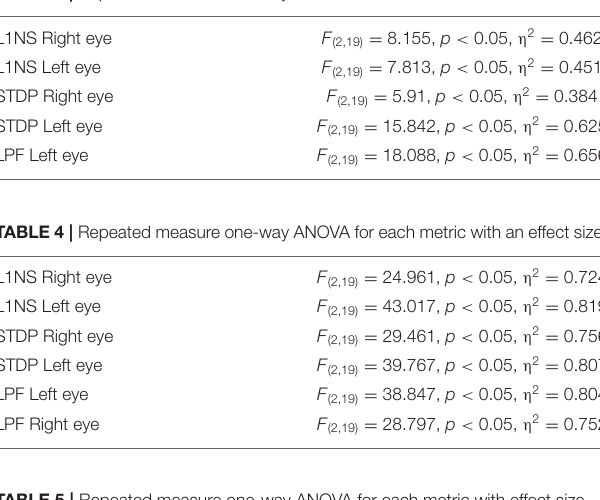
TABLE 3 | Repeated measure one-way ANOVA for each metric with an effect size.